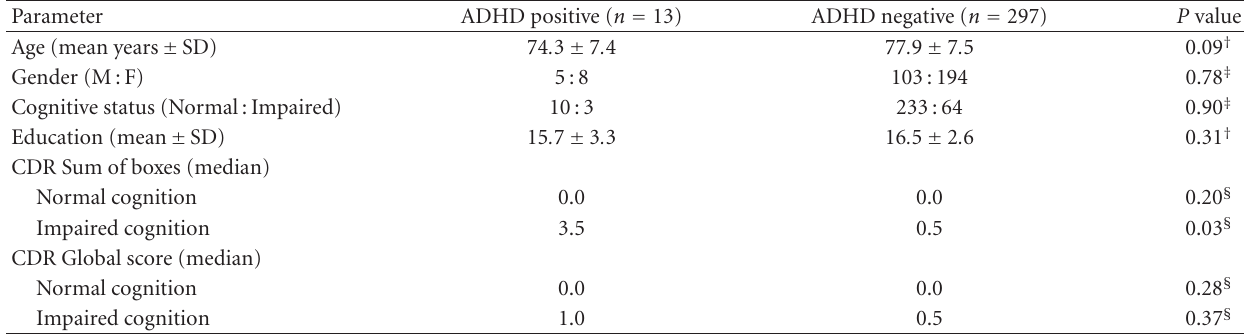
Table 1: Demographic and clinical variables in presumptive positive and negative childhood ADHD subjects as determined by Wender-Utah Rating Scale score.